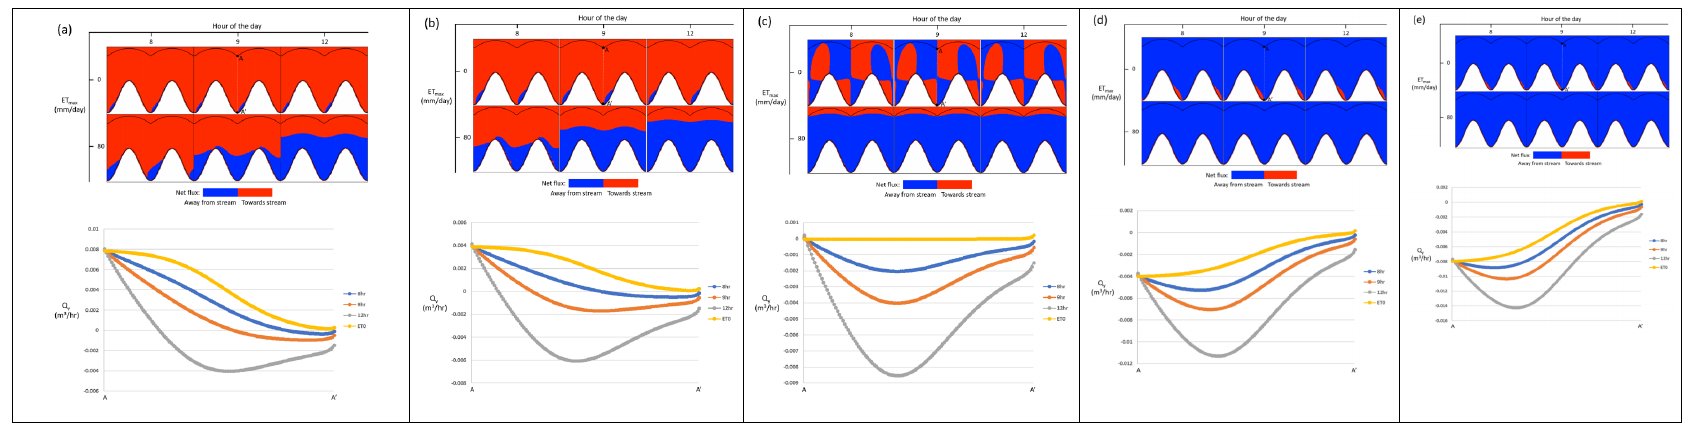
Figure 4. Snapshots of net Q y values at different h of the day ( top row ), as a function of maximum daily ET and regional groundwater flux ( J y/x ; positive for gaining, negative for losing). Profiles of the above Q y (positive towards the stream) values along the middle of the vegetated area of interest ( bottom row ). Note that the no-ET scenario is unchanging with time and plotted only once on each profile. Columns correspond to simulations where the magnitude of J y/x was, respectively, ( a ) 2, ( b ) 1, ( c ) 0, ( d ) − 1, and ( e ) − 2.